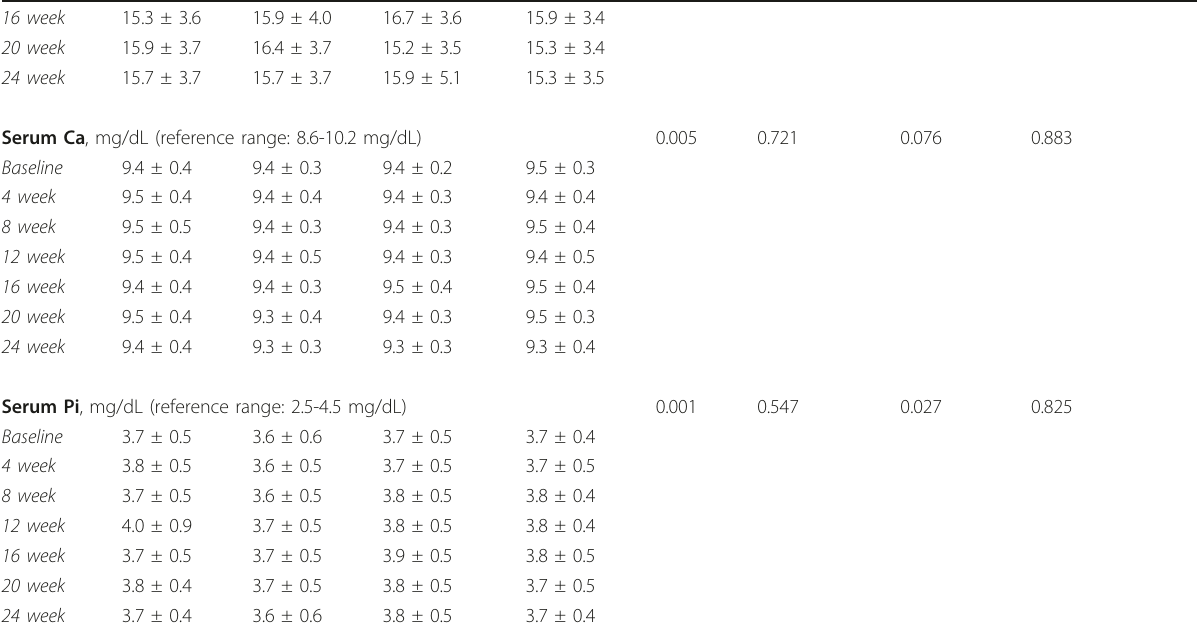
Table 2 Effect of green tea polyphenols supplementation and Tai Chi exercise on blood chemistry in postmenopausal osteopenic women